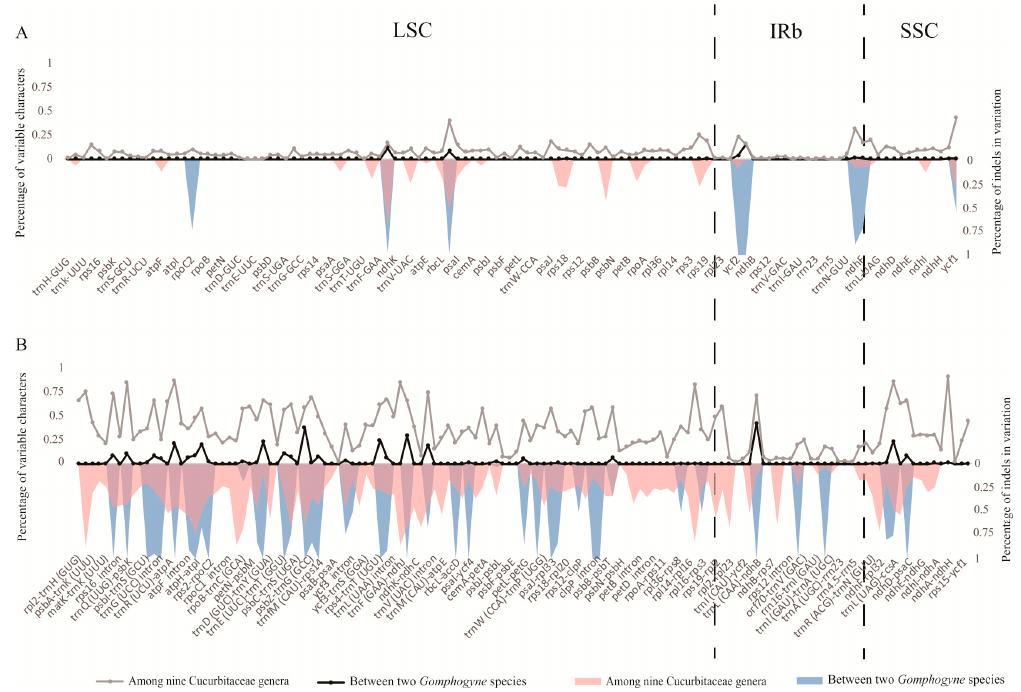
Figure 4. Percentage of variable characters in aligned Cucurbitaceae chloroplast genomes. ( A ) Coding region (CDS) and ( B ) Noncoding region (CNS). These regions are oriented according to their locations in the chloroplast genome.